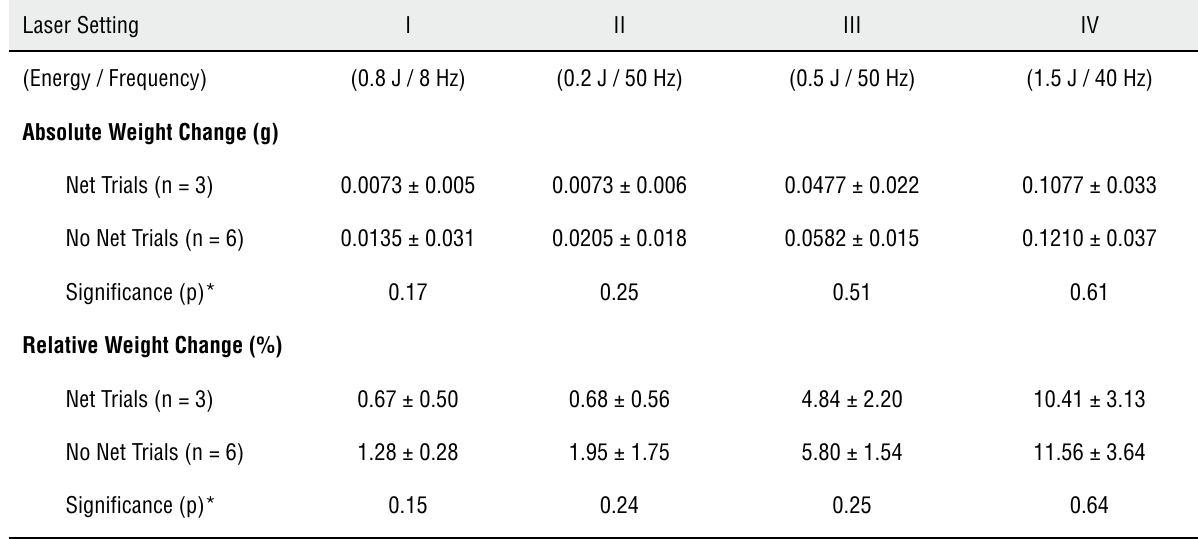
Table 1 – Comparison of absolute and relative weight change between net and no net trials within each laser setting. Laser